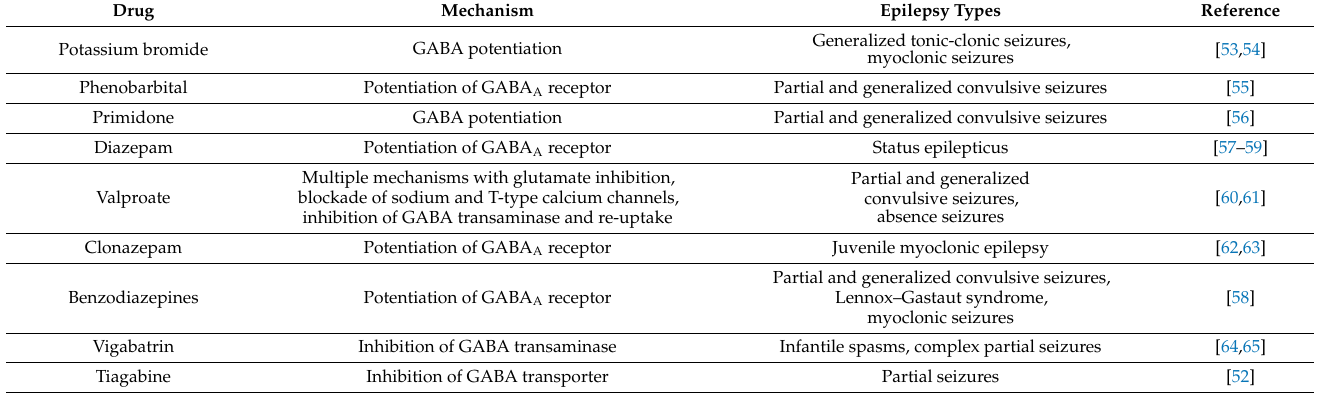
Table 2. Current antiepileptic drugs with GABAergic